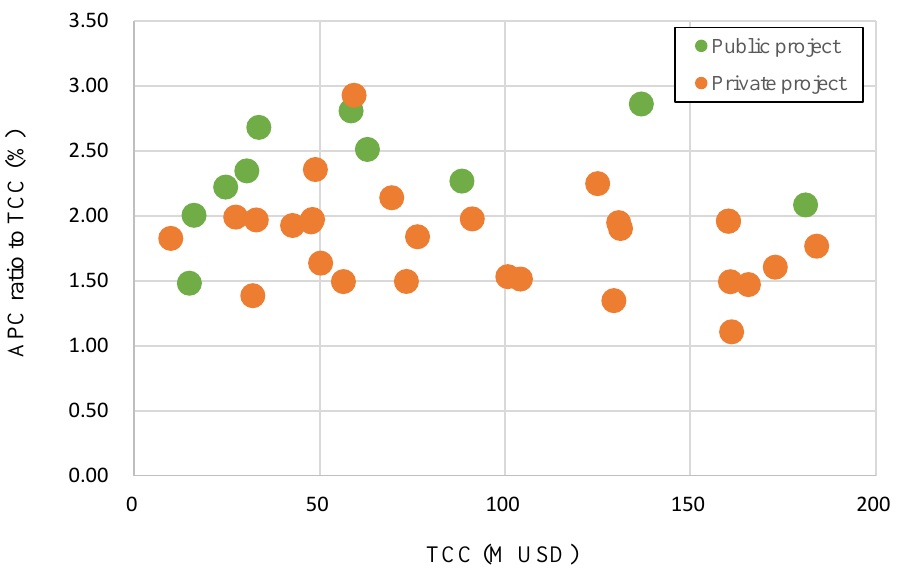
Figure 6. Plots of APC to TCC rations for different client types. Table 11. Independent sample t-test outcomes.